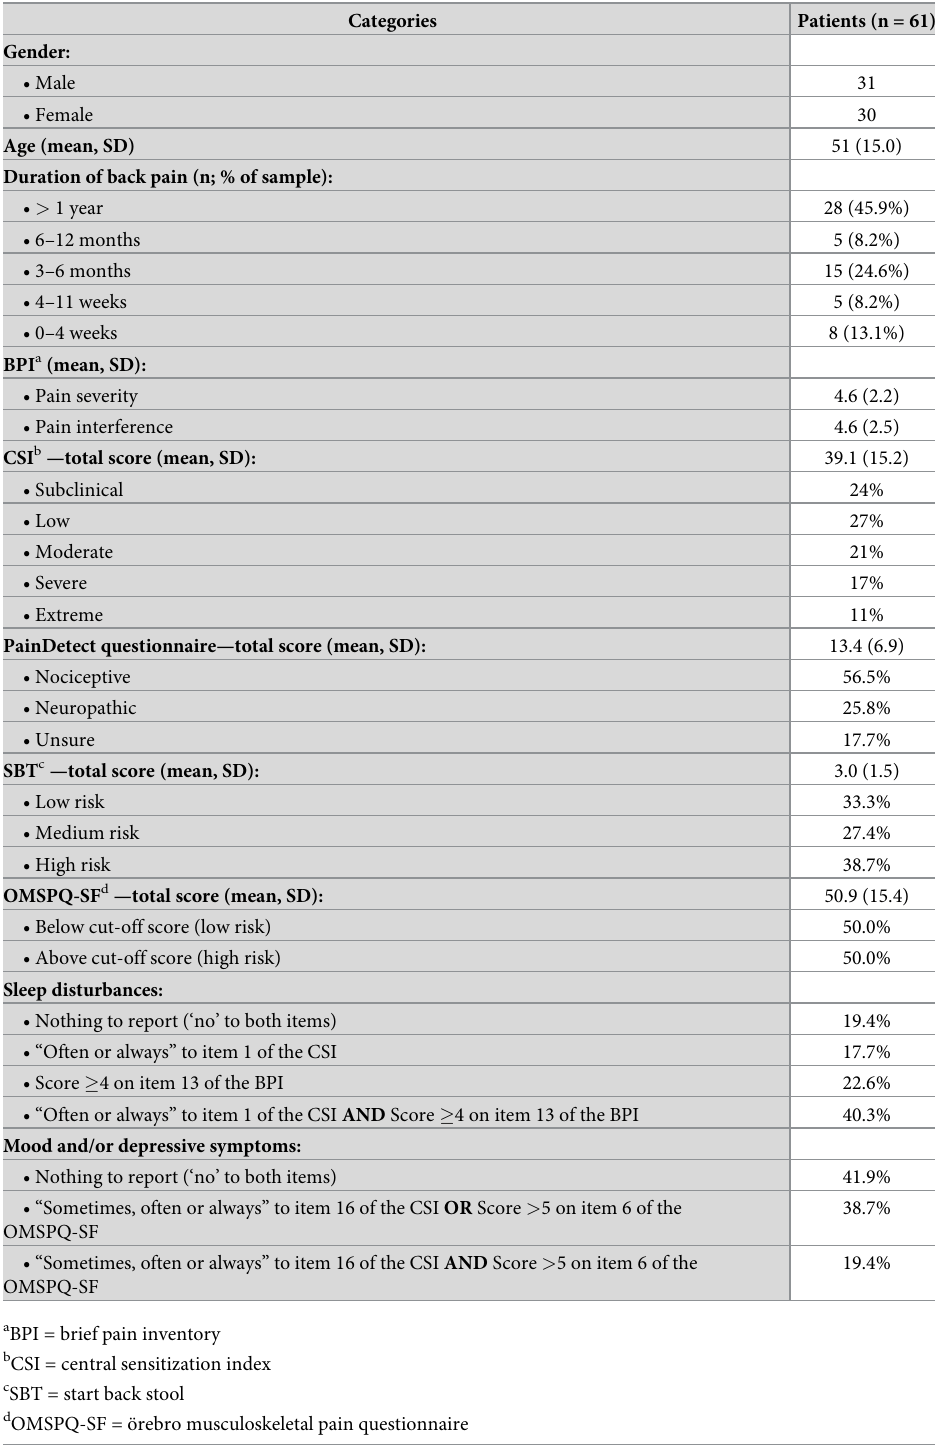
Table 3. Patients’ sociodemographic and clinical characteristics at